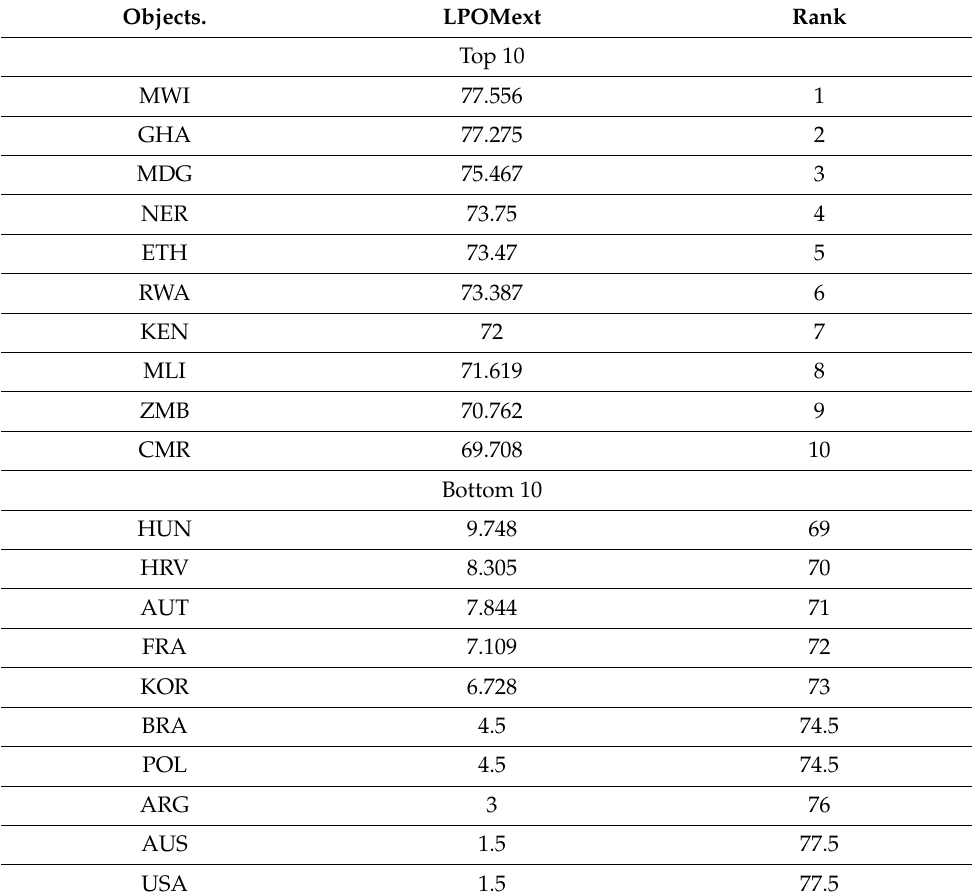
Table 14. Results of a linearization by LPOMext [33].